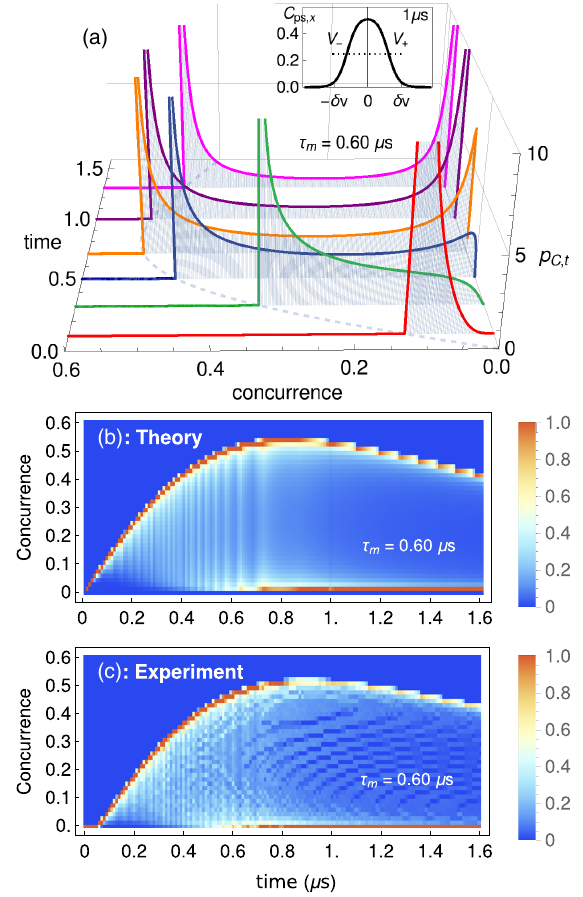
FIG. 2. Concurrence distribution for the qubits under the half- parity measurement. In panel (a) we plot the concurrence probability density function, Eq. (10), for different values of time. The values of time for the presented curves are chosen so as to see their unique features as they develop. The grey dotted curve joining the high-concurrence peaks shows the concurrence upper bound, Eq. (11). The inset shows an example of how the concurrence (at time t ¼ 1 μ s) varies as a function of the readout V . Panels (b) and (c) are the histograms of the concurrence at any t time points from t ¼ 0 to T ¼ 1 . 6 μ s (with a step size 0 . 01 μ s), comparing theory and experimental data. For the theory plot, we c Þ in Eq. (10) by integrating it coarse-grain the distribution p C ;t ð with a pixel size δ c ∼ 0 . 015 , which is the bin size of the experimental histogram. For presentation purposes, a histogram at any time t is normalized by its maximum